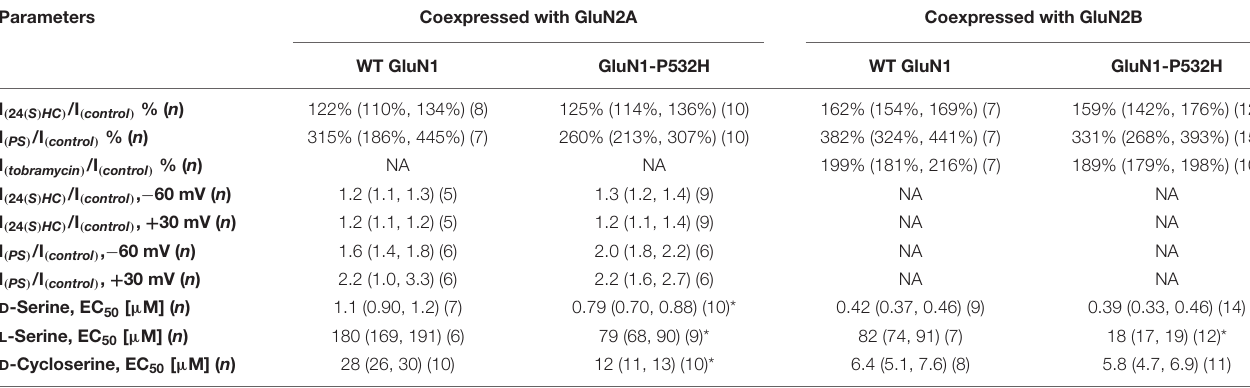
TABLE 2 | Summary of rescue pharmacology.